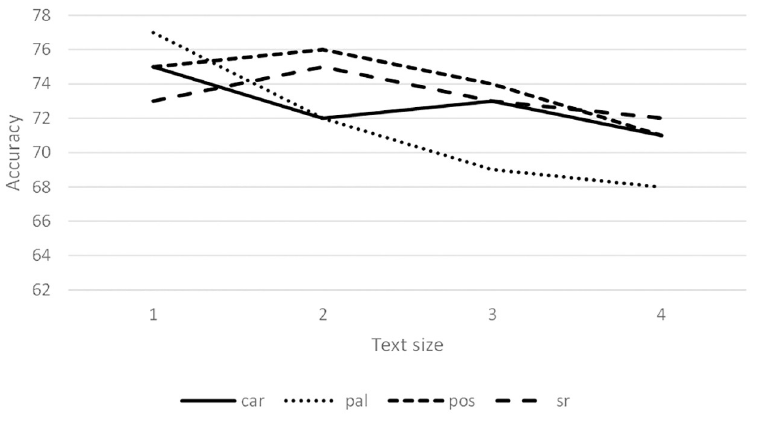
Fig 7. Average of the accuracy (%) using PCA